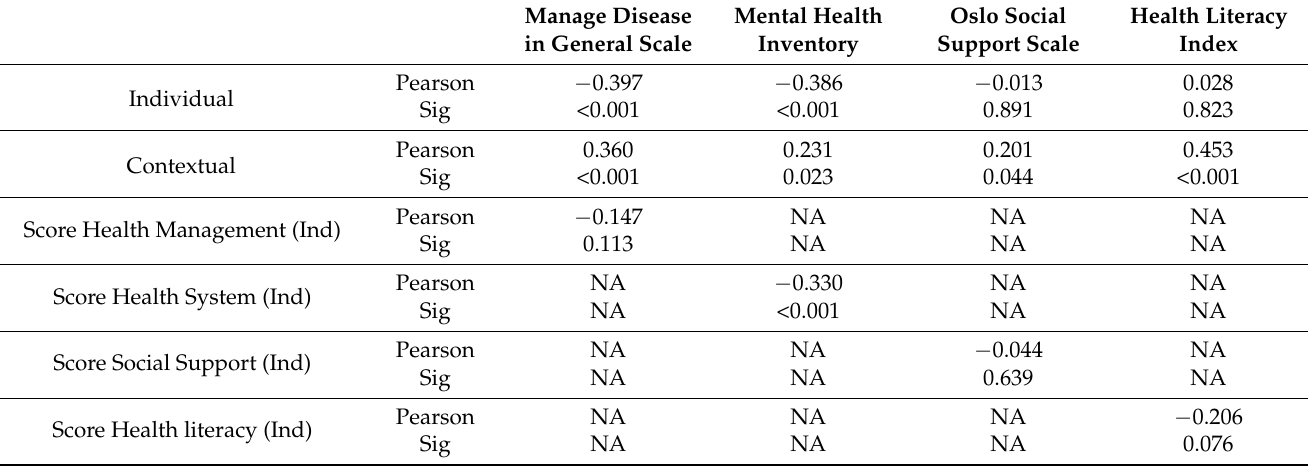
Table 6. Construct